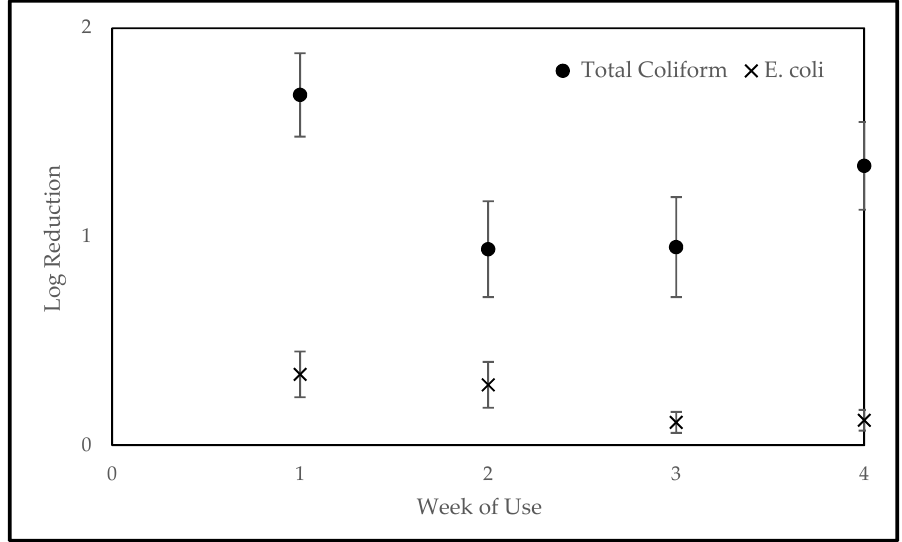
Figure 14. Box and whisker plot of E. coli bacteria concentration in water taken from the home and intervention spigot over four weeks. ( a ) displays the log of E. coli bacteria concentration in water taken from untreated source water used by the household to fill the intervention. ( b ) displays the log of E. coli bacteria concentration in treated water from the spigot. In each figure, the top and bottom boxes in each column represent the second and third quartile of the data, respectively. The line that separates them indicates the median, and the lower and upper whiskers indicate the first and fourth quartile of the data.